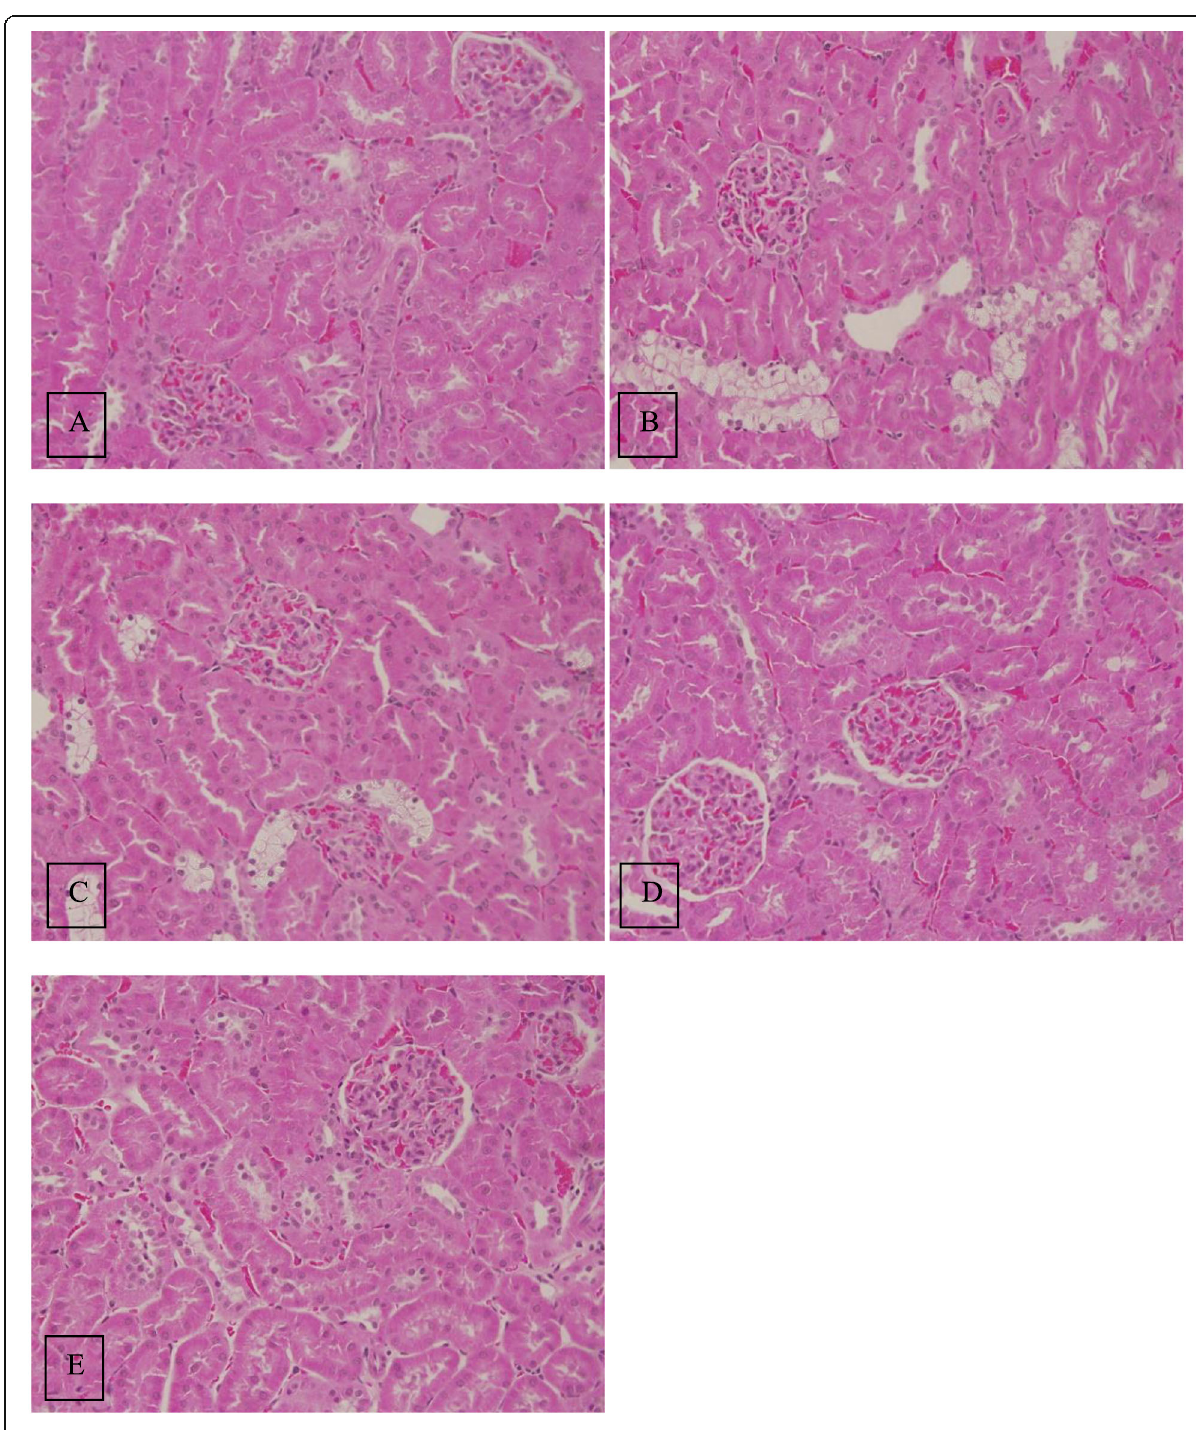
Fig. 8 All sections of Kidney stained with (H & E) were viewed and evaluated for pathological changes by using a light microscope (Eclipse i80, Nikon, Japan). The required images were taken with Nikon mounted digital camera (OXM 1200C, Nikon, Japan (400X). a - Normal, Control, b - Received APAP 1000 mg/kg, c - DPP (50 mg/kg) + APAP, d - DPP (100 mg/kg) + APAP, e - Silymarin +